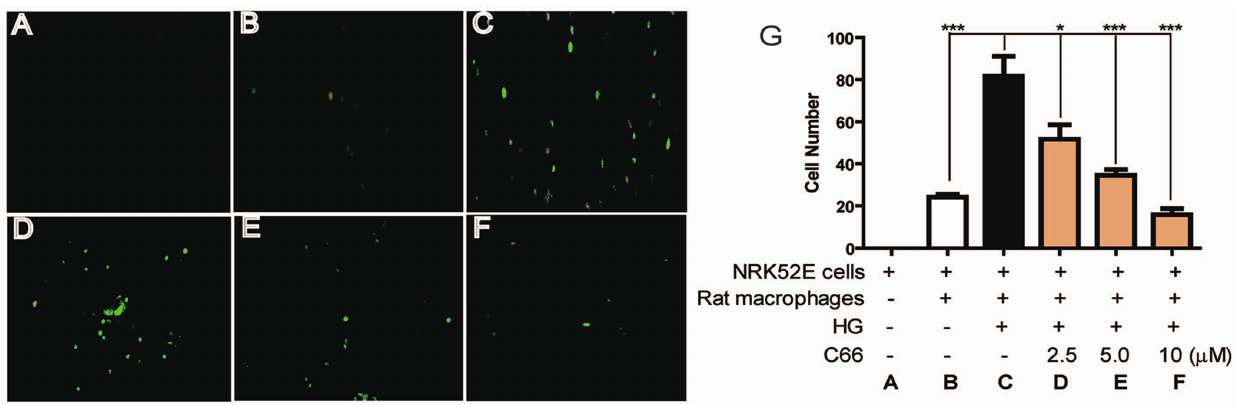
Figure 4. C66 dose-dependently inhibited glucose-induced epithelial-macrophage adhesion (green spots showed the location of macrophages in NRK-52E cell cultured plate. The bar graph represents the number of attached macrophages in five randomly selected optical fields per well, and expressed as mean 6 SD of three independent experiments (* p , 0.05, *** p , 0.001).